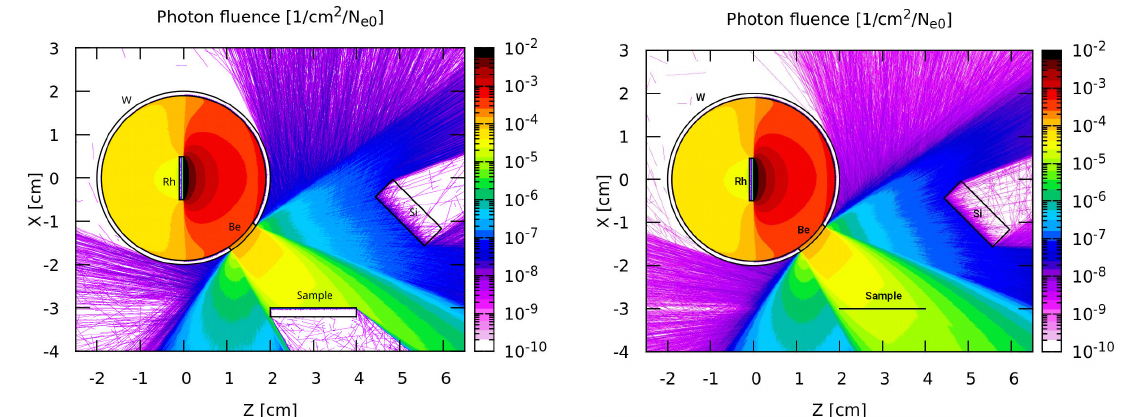
Figure 1. Experimental setup and photon fluence reproduced in the calculations for the sample thickness of 2 cm ( left ) and 1 µm ( right ).